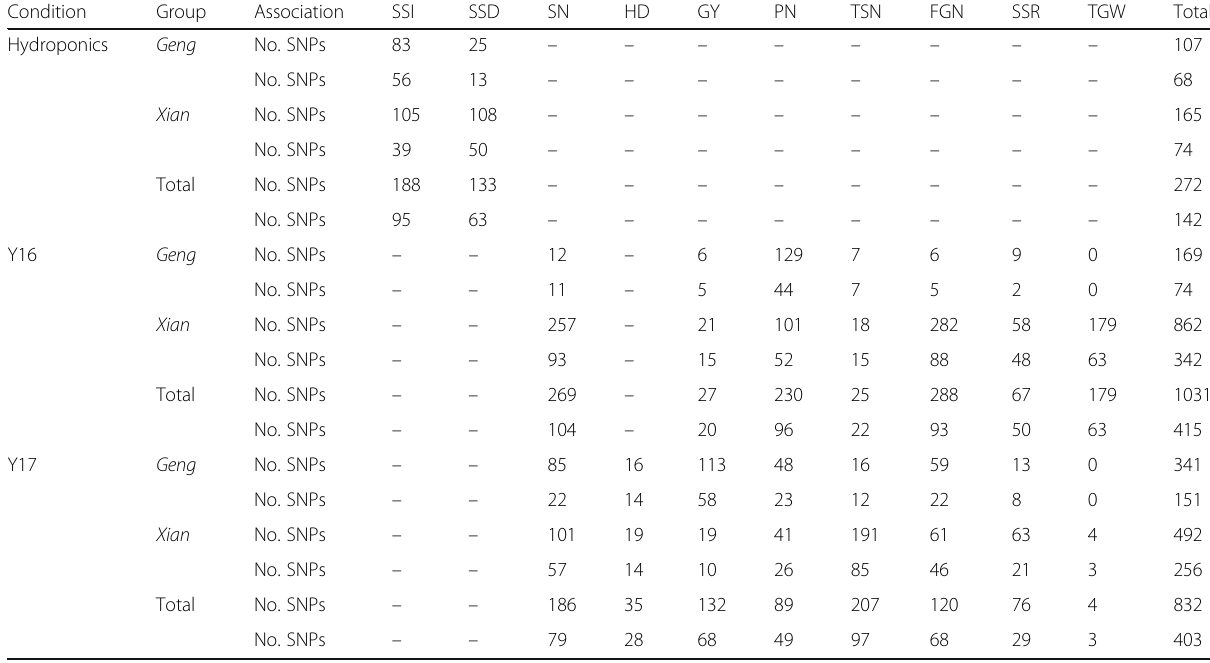
Table 3 Summary of the GWAS results for all 10 measured traits